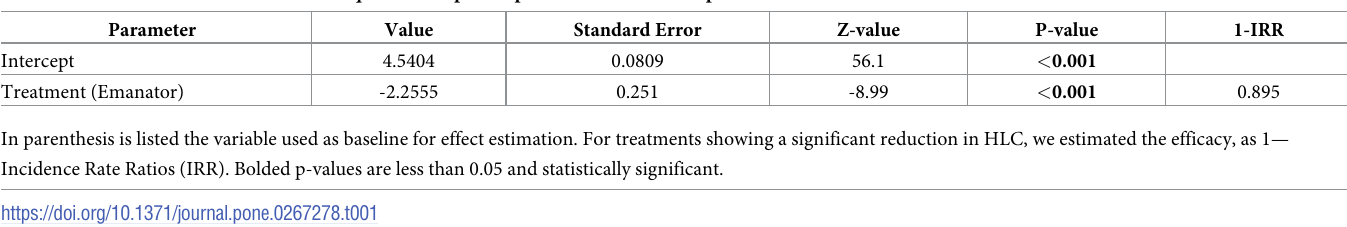
Table 1. Parameter estimates of Aedes albopictus HLC post-exposure to an emanator placed next to human outdoors. Parameter